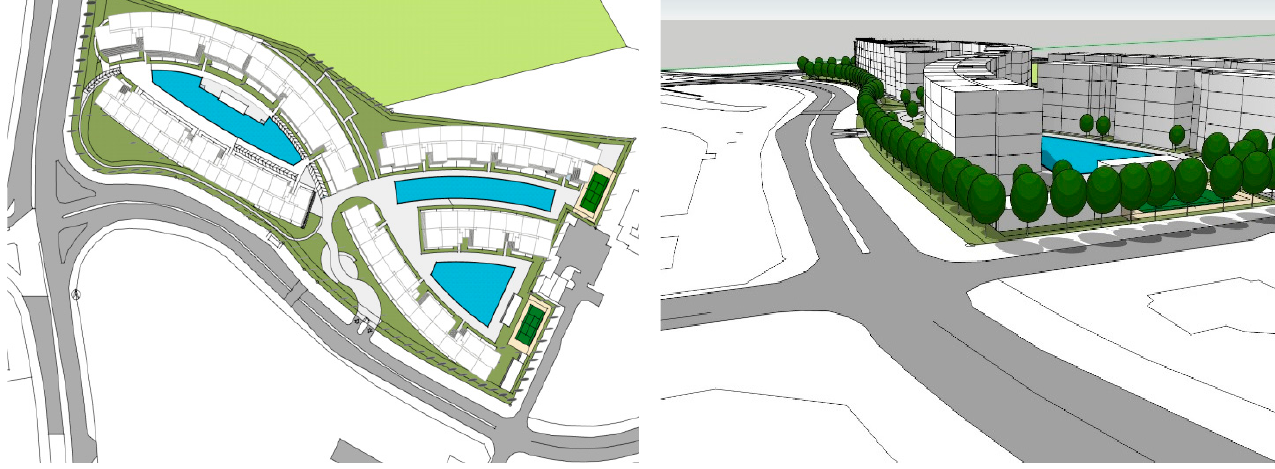
Figure 6. The study area for PVSB [47].